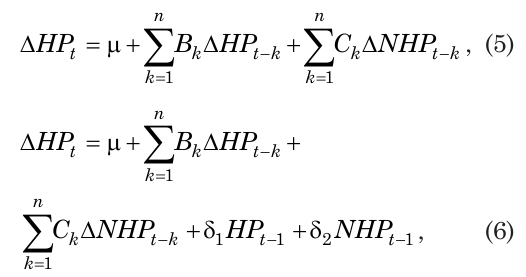
CPI to be estimated. The null hypothesis for the F -statistic is δ relationship or no co-integration).